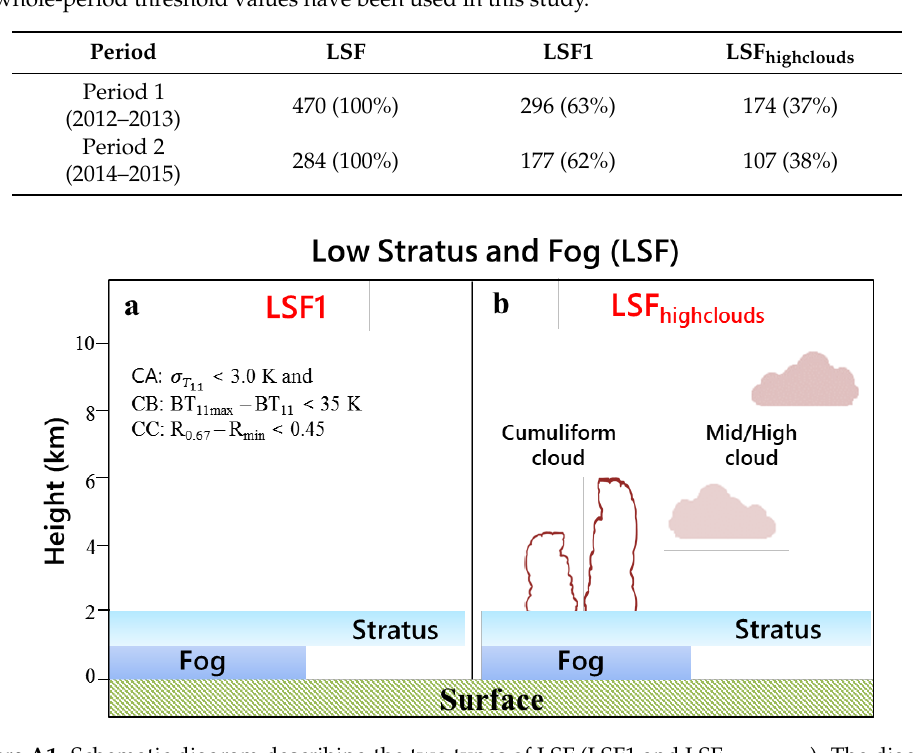
Figure A1. Schematic diagram describing the two types of LSF (LSF1 and LSF highclouds ). The diagram has been modified from Figure 5 of Yoo et al. [8] using different CA, CB, and CC criteria. Details of the criteria are explained in the text.